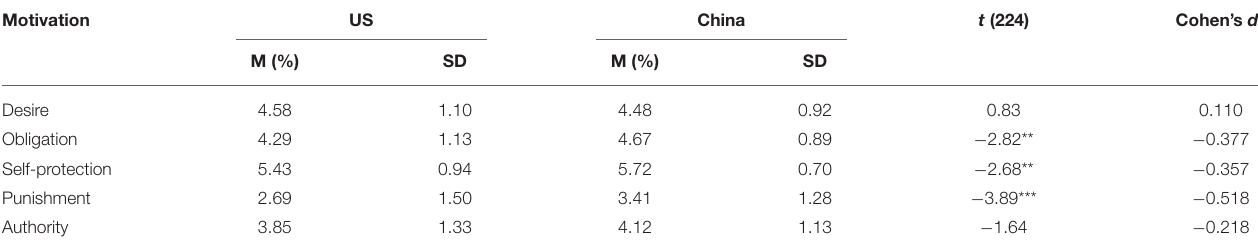
TABLE 4 | Descriptive data for motivations included in importance rating measure among Chinese and American participants.